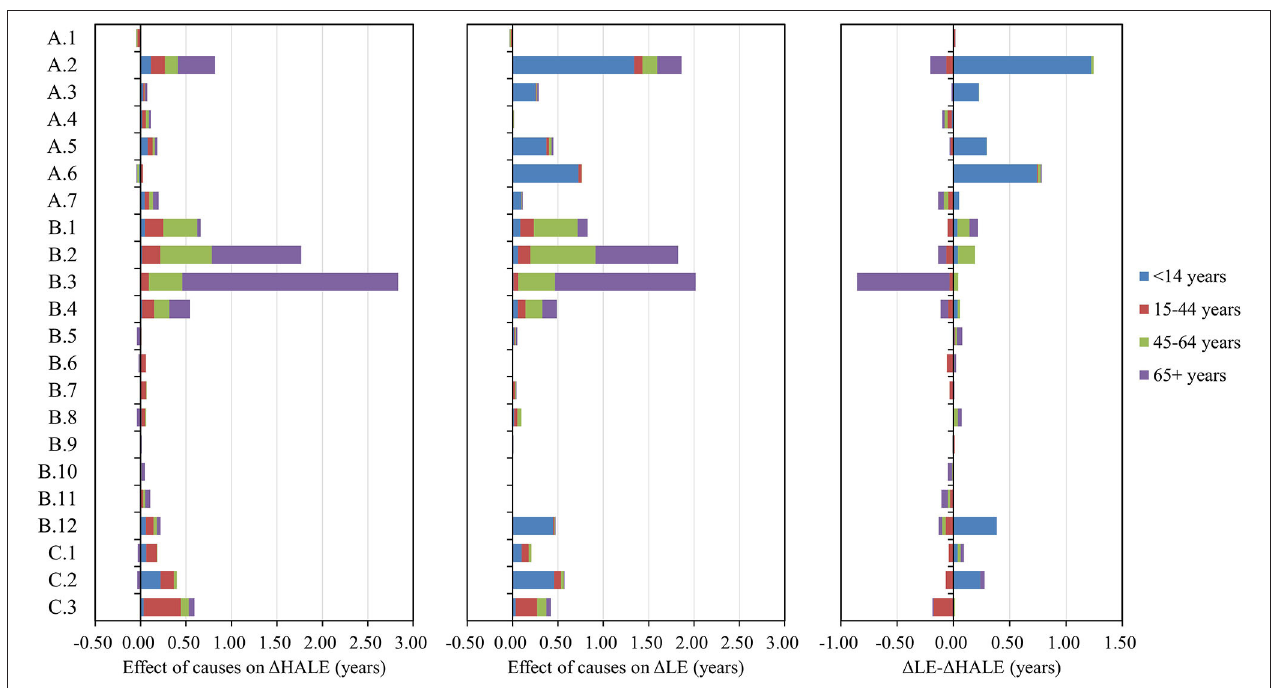
FIGURE 4 | Cause-specific effects on changes in life expectancy (LE) and health-adjusted life expectancy (HALE) (levels 1–2) for different age groups from 1990 to